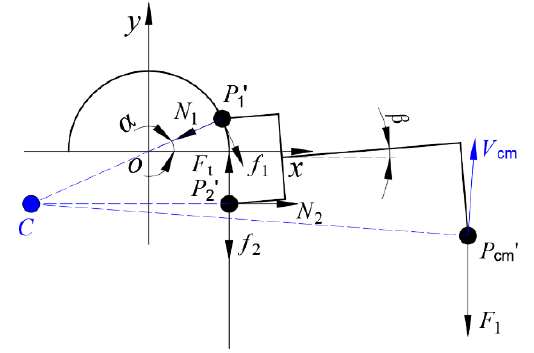
Figure 5. Force analysis diagram of the manipulator.